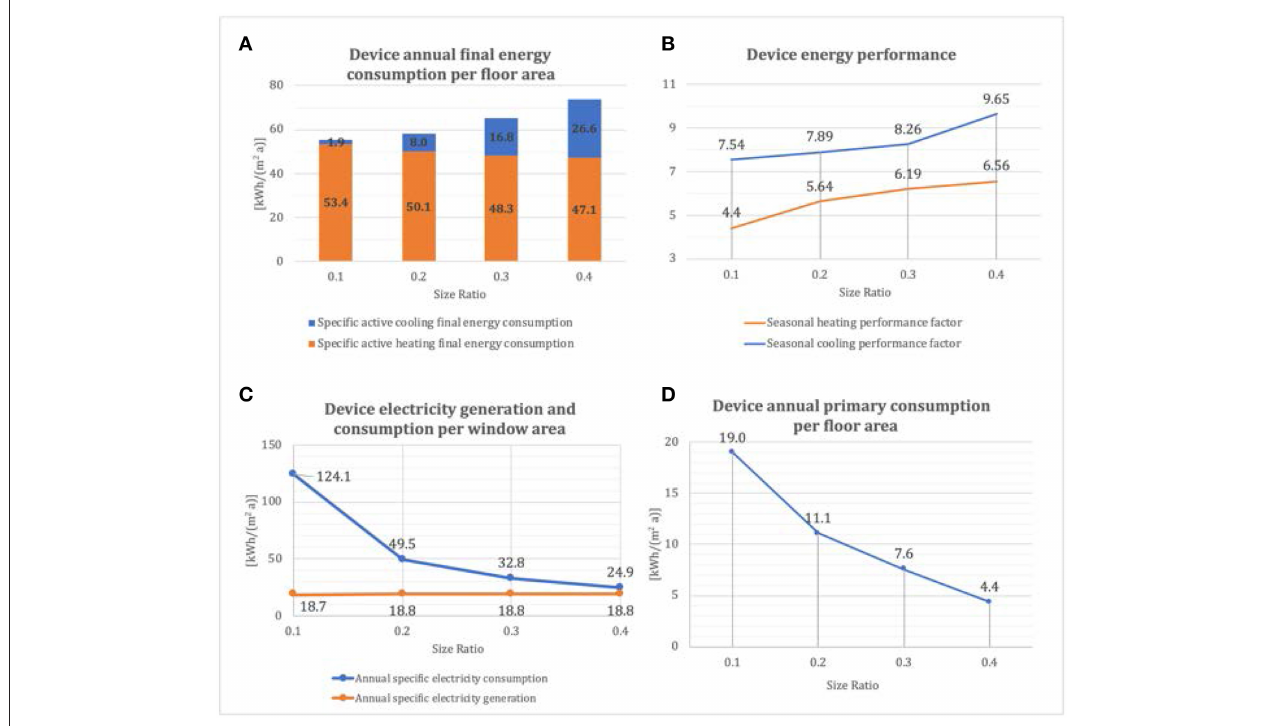
FIGURE 13 | Final energy consumption (A) , energy efficiency (B) , electricity generation and consumption (C), and primary energy consumption (D) for a lowly-occupied office room and variable window-to-floor area ratios, implementing fluidic IGUs (see text for details).